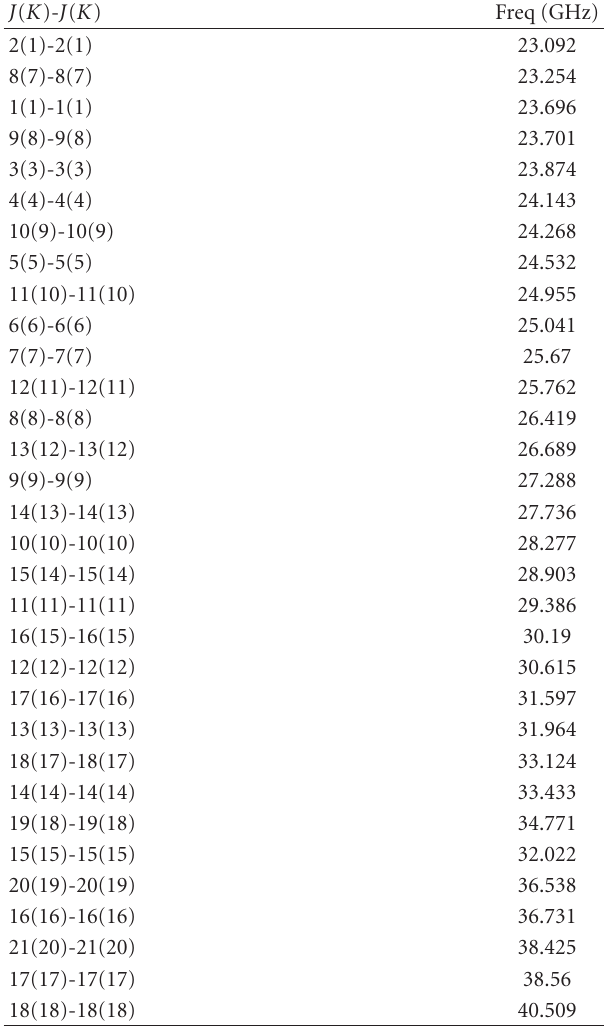
Figure 4: Logarithmic scale results of measurements: (a) larger scale with di ff erence; (b) smaller scale for magnitude comparison.